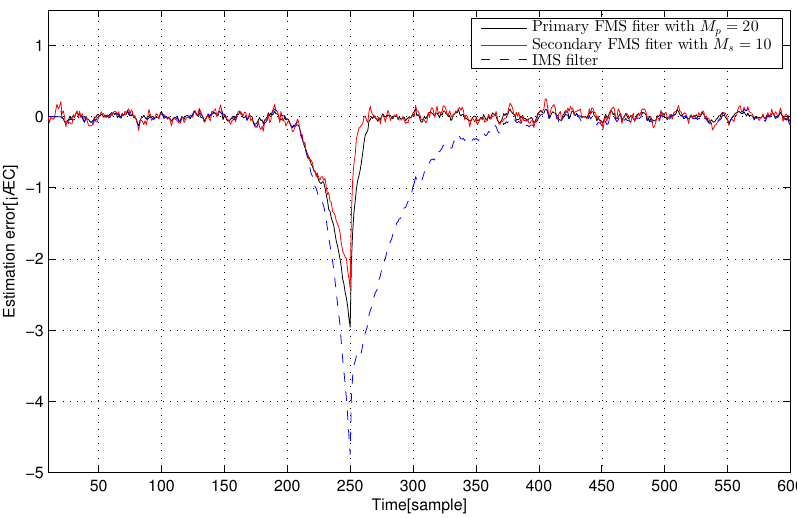
Figure 4. Estimation errors of primary FMS, secondary FMS and infinite memory structure (IMS) filters for the F404 gas turbine aircraft engine